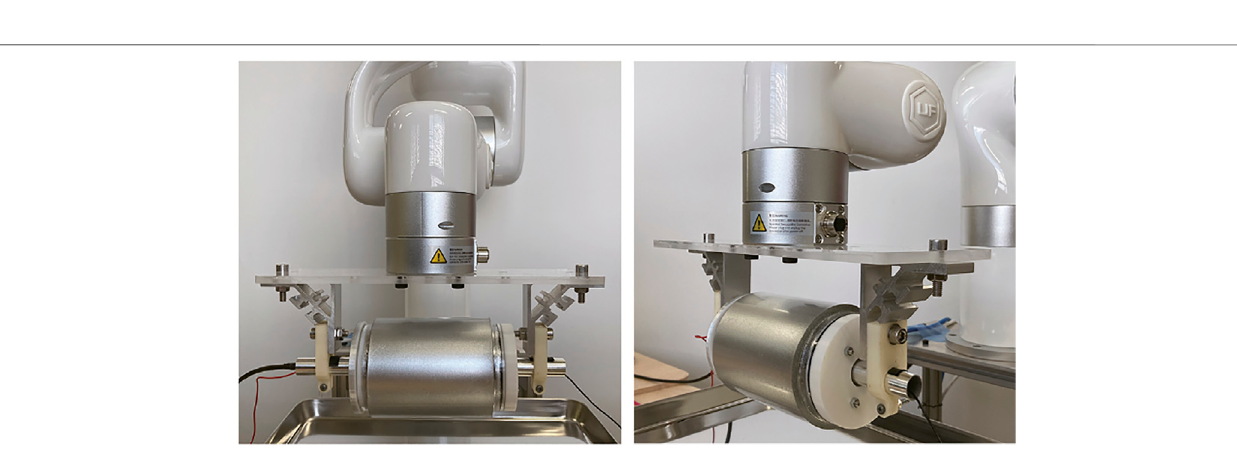
Frontiers in Robotics and AI |